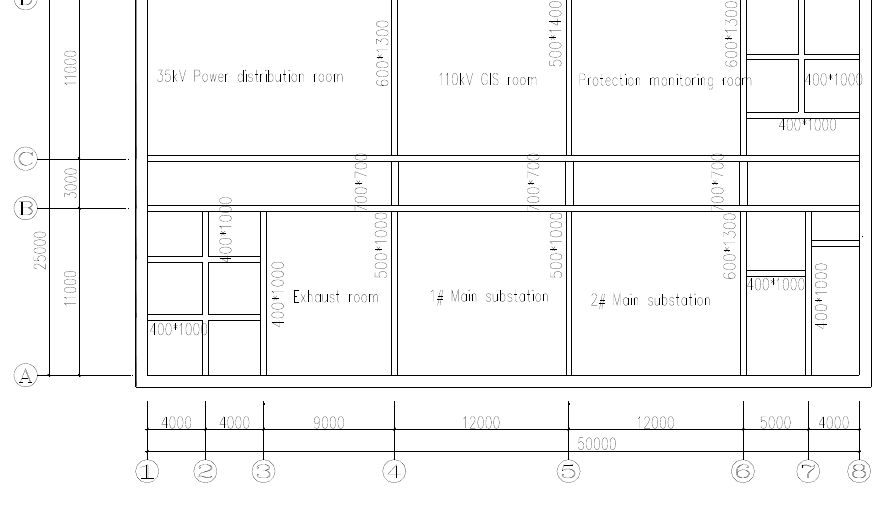
Figure 1. Plan of the second floor.